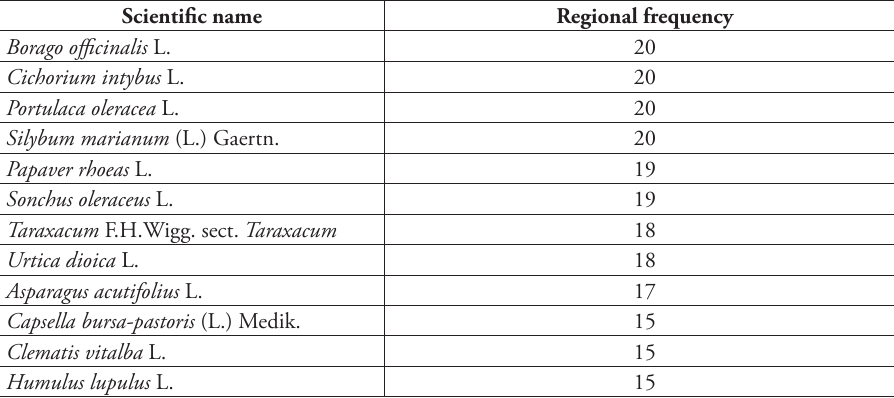
Table 1. Species with higher frequency in Italian